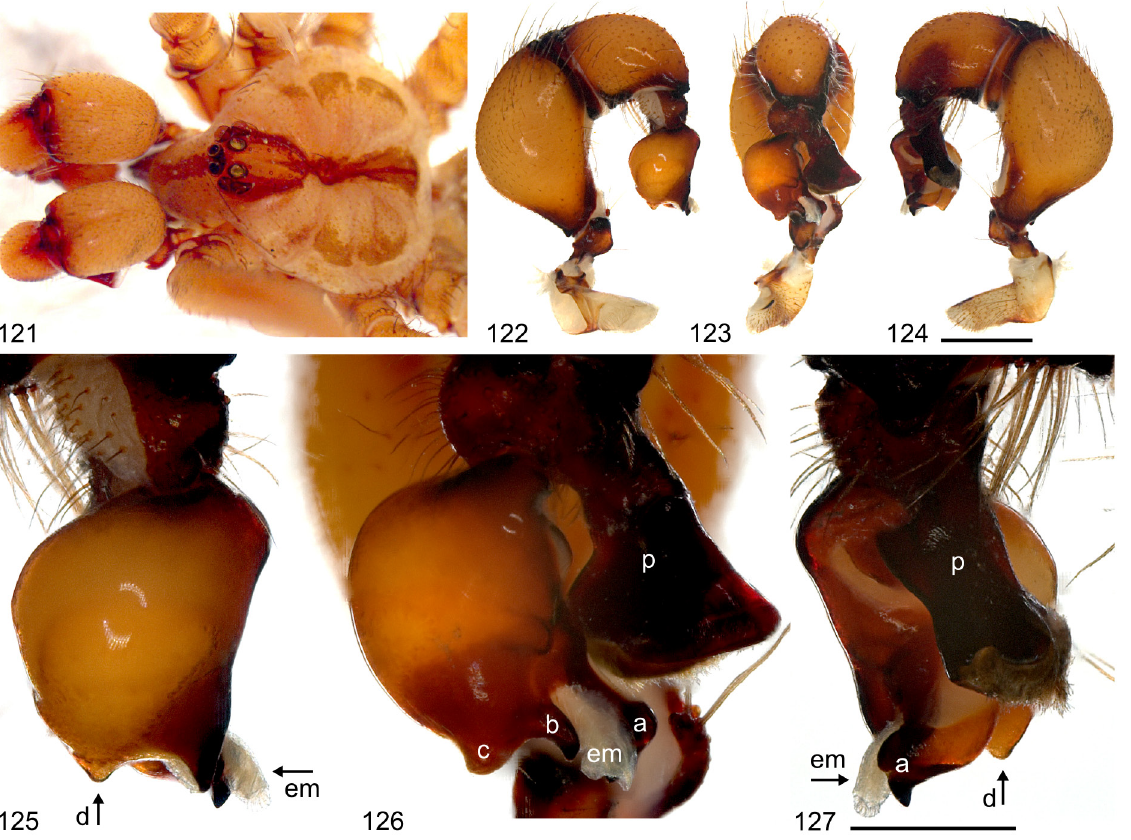
Figs 121–127. Artema transcaspica Spassky, 1934. 121 . ♂, habitus (ZIN type vials). 122–124 . Male left pedipalp (ZMMU, Uzbekistan, near Zarafshon): prolateral, dorsal, and retrolateral views. 125– 127 . Male left bulb and procursus: prolateral, dorsal, and retrolateral views. Scale lines: 122–124 = 1 mm; 125–127 = 0.5